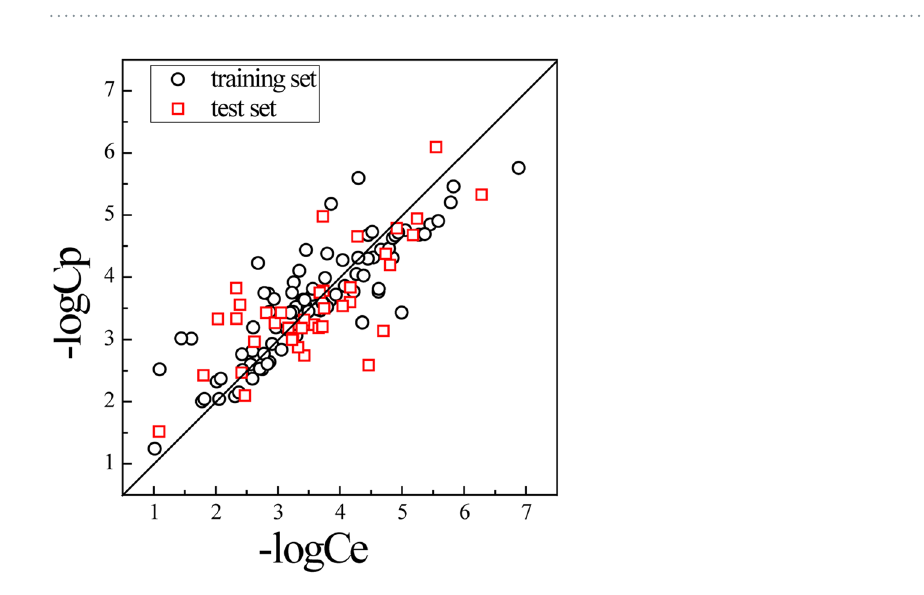
Table 5. Predictive performance among internal and external validation.